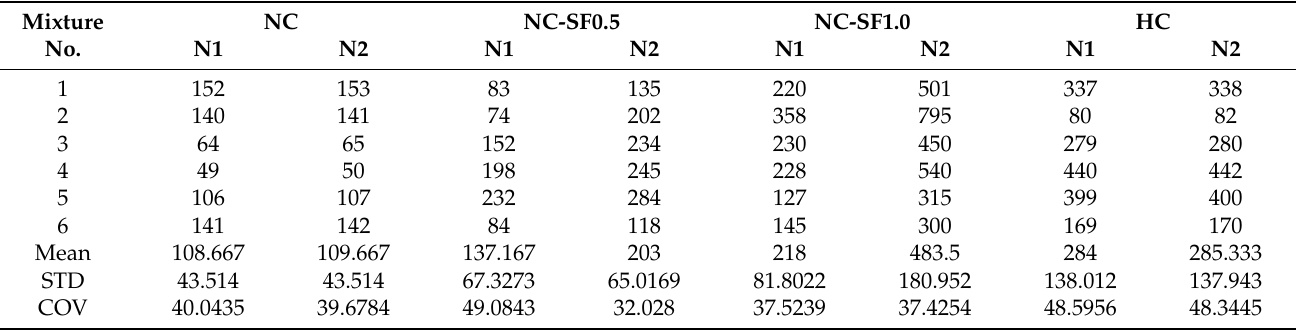
Table 3. Cracking and failure impact numbers of Batch